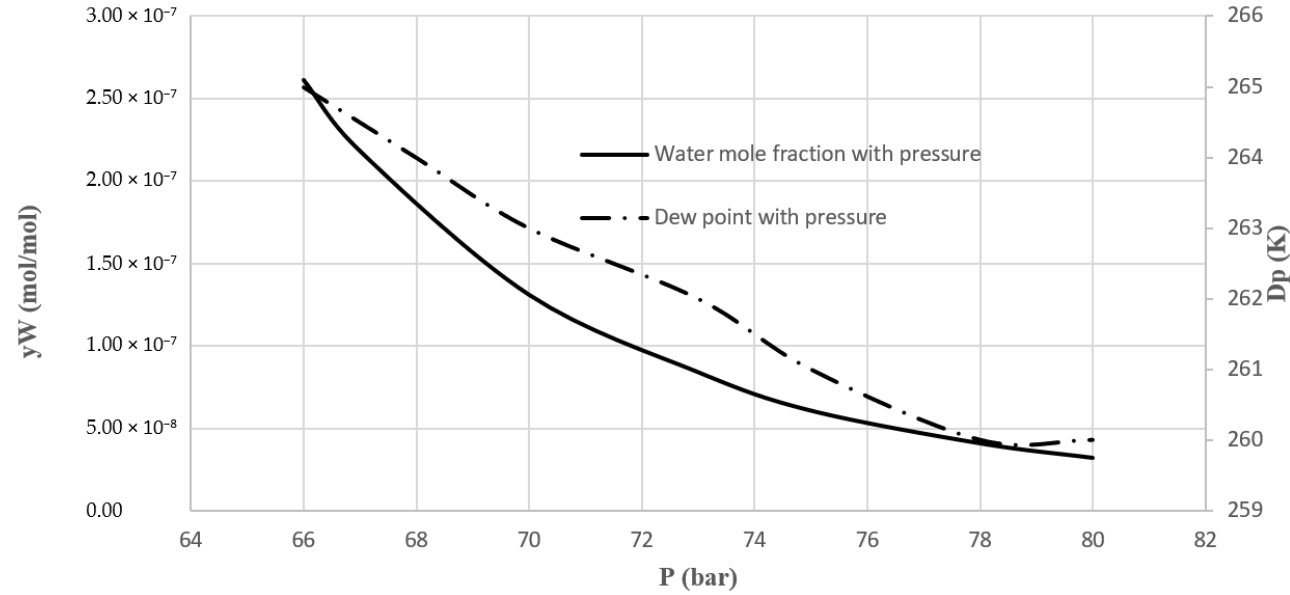
Figure 18. Hexane regeneration with time.